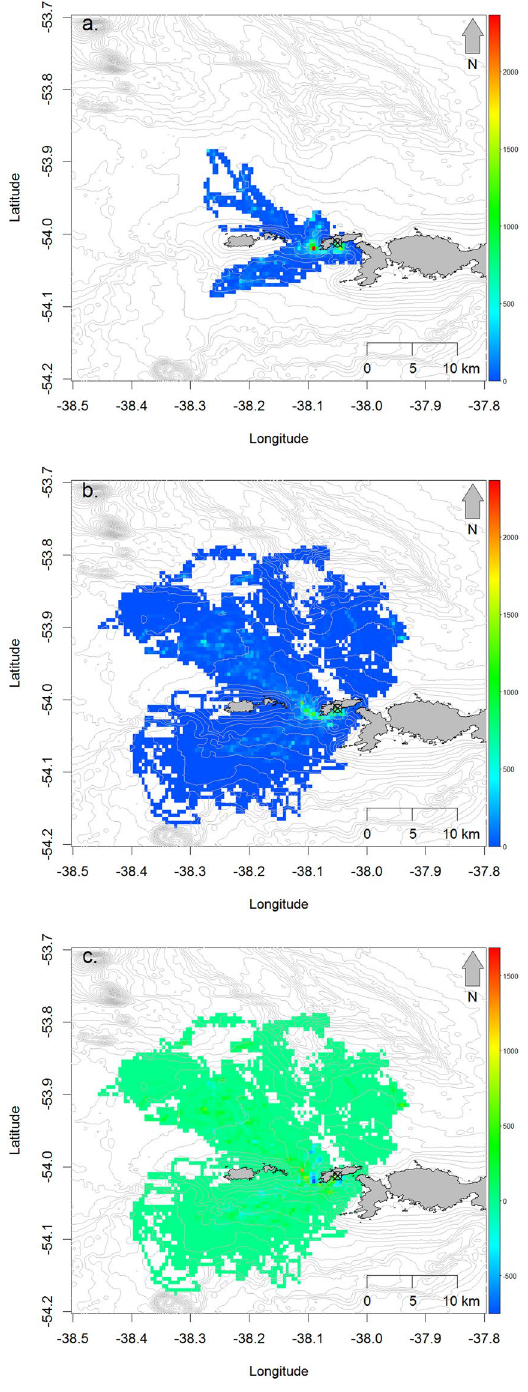
Figure 2. Number foraging dives per day within 0.005 decimal degrees grid cells by gentoo penguins from the Landing Beach and Square Pond colonies during ( a ) incubation, ( b ) chick-rearing and ( c ) the difference between the two (chick-rearing minus incubation densities). Maps were created by the authors using R version 3.4.2 (R Core Team. R: A language and Environment for Statistical Computing . R Foundation for Statistical Computing, Vienna, Austria. https://www.R-project.org